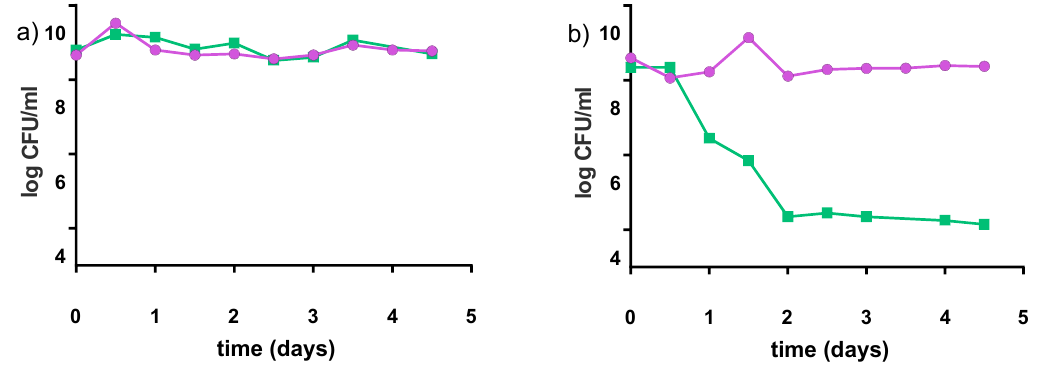
Figure 8. Survival of S. thermophilus C106 ( ■ ) and L. rhamnosus GR-1 ( ● ) during storage at 22 °C for five days; ( a ) milk-based formulation (4% pre-treated millet in milk, 5% sucrose); ( b ) water-based formulation (8% pre-treated millet in water, 5% sucrose). Mean values are based on two independent replicates.